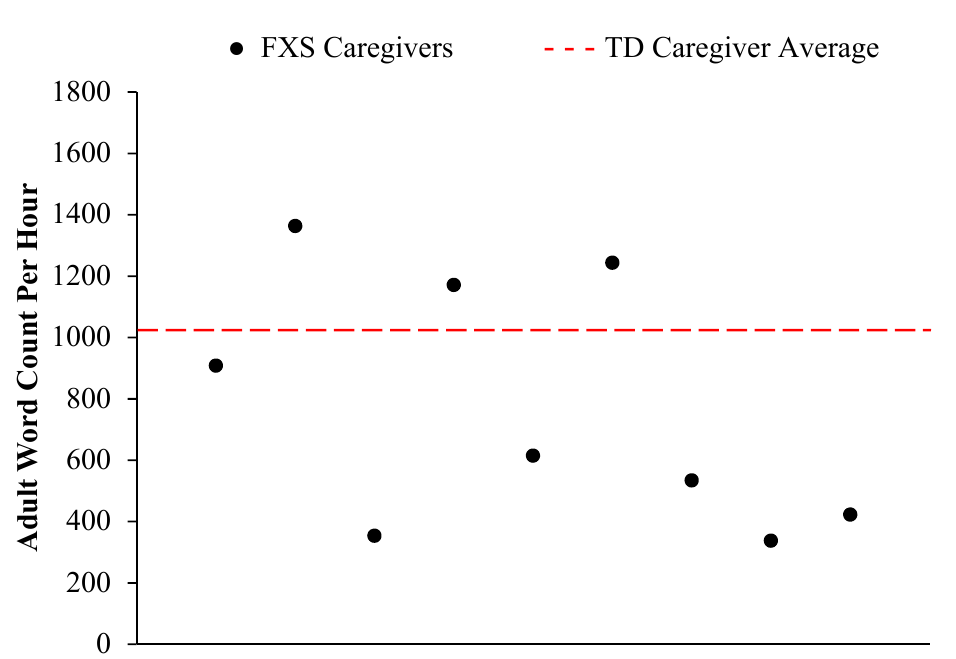
Figure 3. Caregivers’ of infants and toddlers with FXS adult word count per hour plotted in comparison to the average adult word count per hour in TD caregivers ( M = 1024.75).